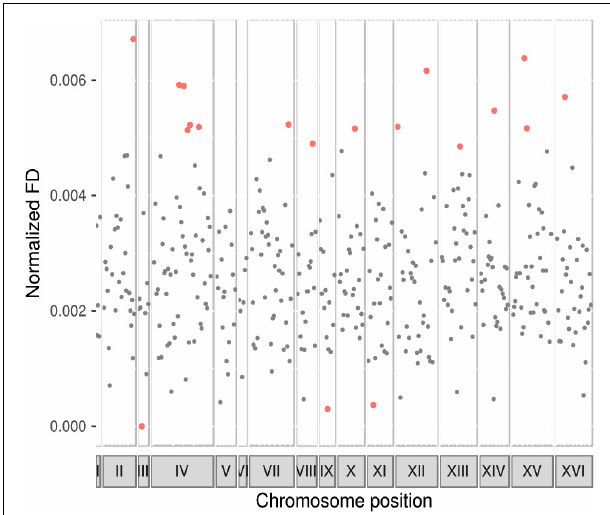
FIGURE 2 | Functional divergence along Sk genome. Enriched chromosomal regions in genes codifying for proteins with functional divergence. Points represent the mean of normalized functional divergence values of bins of ten genes and their location in every chromosome. Chromosome length is represented in x-axis and proportionally to the size. The y-axis shows functional divergence normalized values. Black points correspond to those bins that felt into the 95% confidence level of the random distribution. Red points show those bins enriched or impoverished in proteins showing evidence of functional